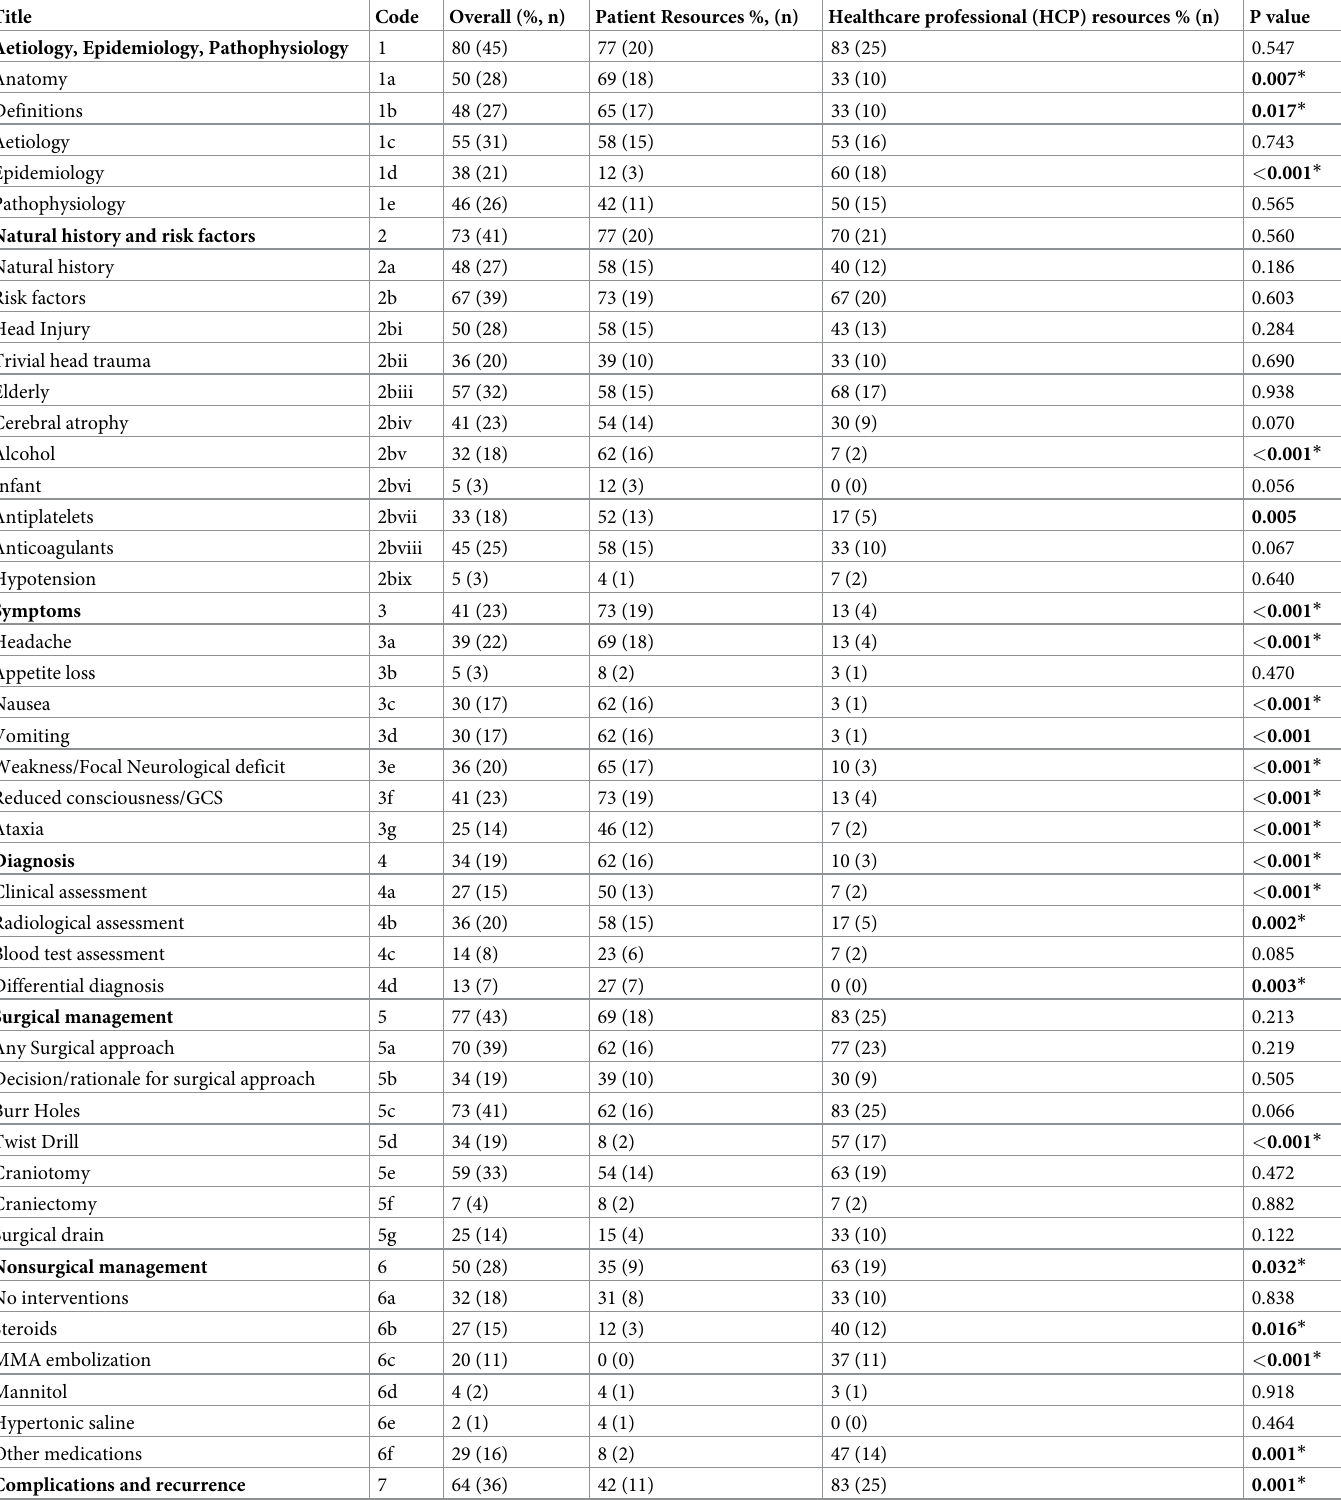
Table 2. Differences in domain components between patient orientated and healthcare professional orientated